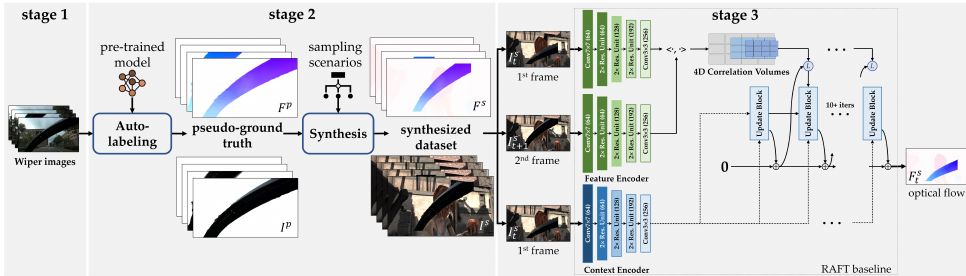
Figure 4. Training pipeline of BTS: ( stage 1 ) data acquisition: we acquired real image data under rainy weather conditions, including windshield wipers; ( stage 2 ) data synthesis: pseudo-ground truth wiper mask and flow data are generated from the collected data using auto-labeling, after which we conduct data synthesis to improve the data diversity of typical optical flow data; ( stage 3 ) training: RAFT baseline [27], a supervised learning-based optical flow network, is adopted to fine-tune its pre-trained models with our synthesized dataset, SintelWipers.